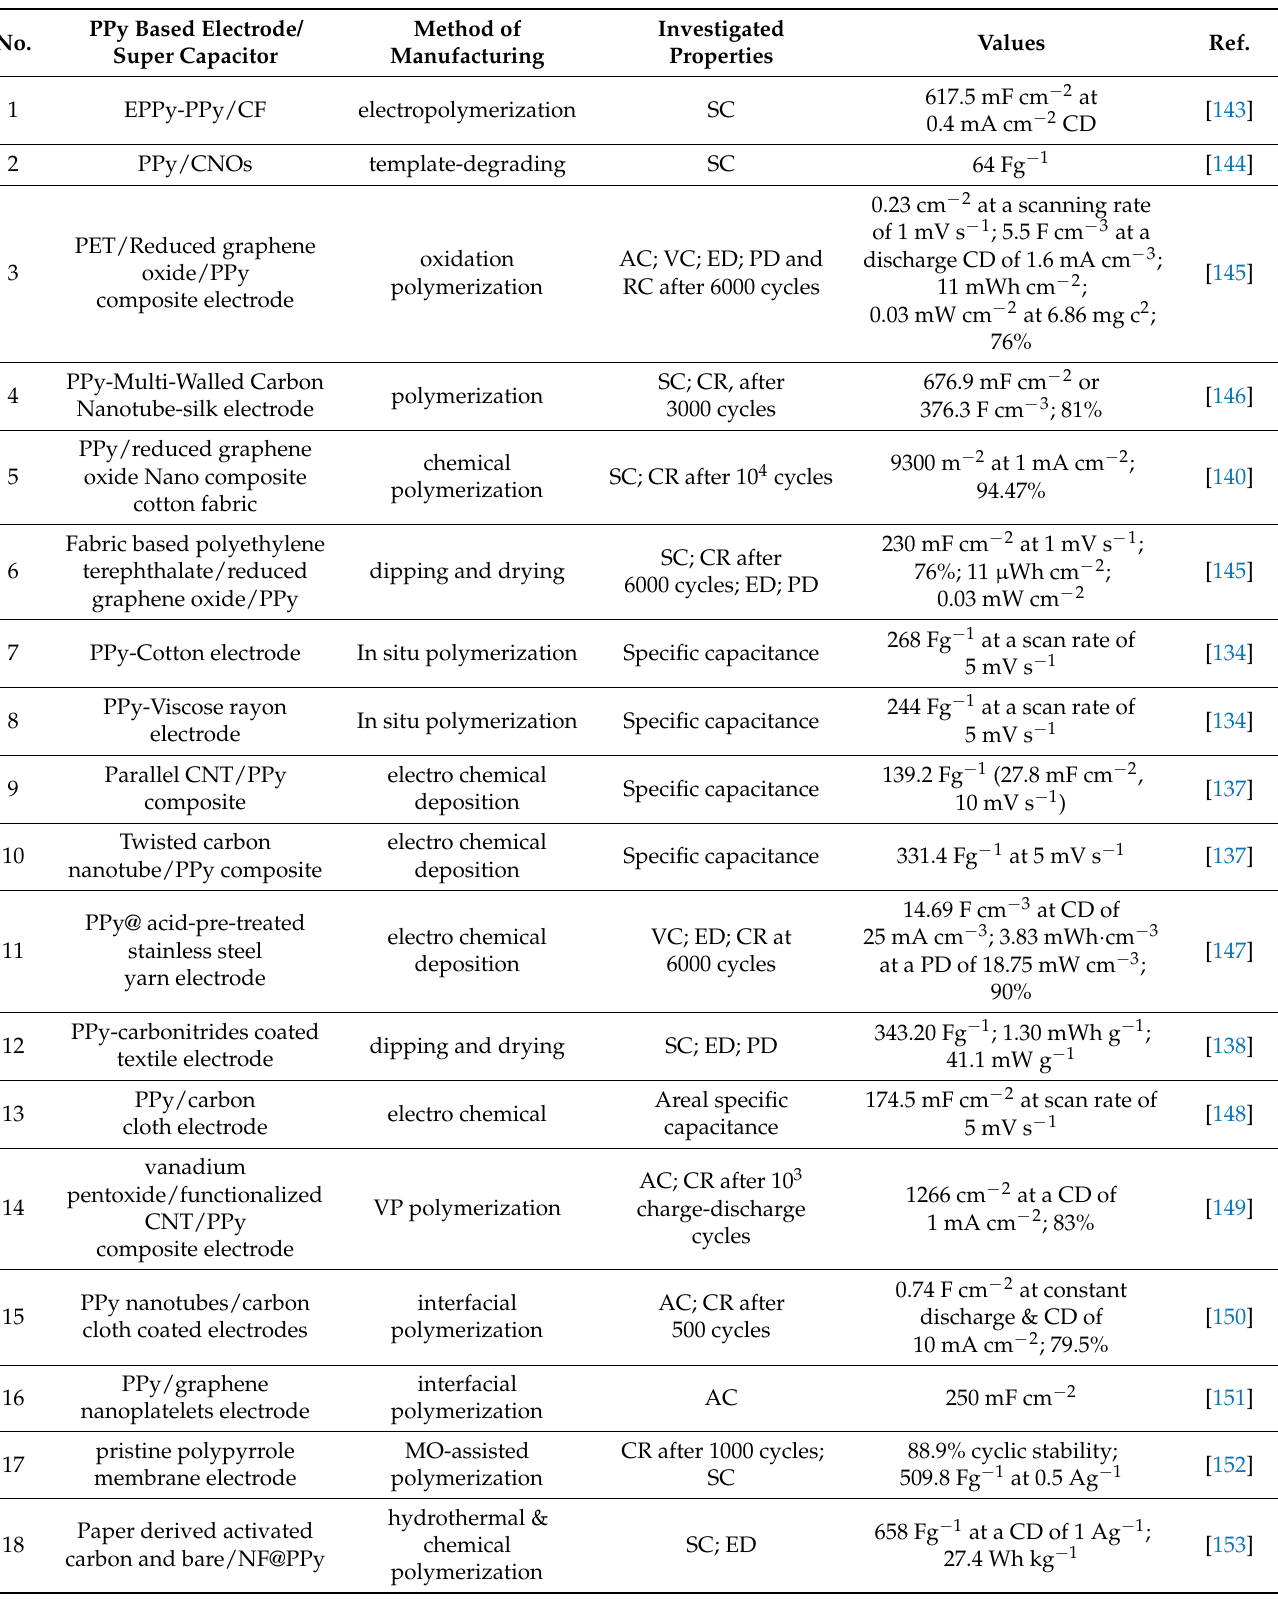
Table 4. Summary of supercapacitors based on PPy in terms of capacitance retention (CR),